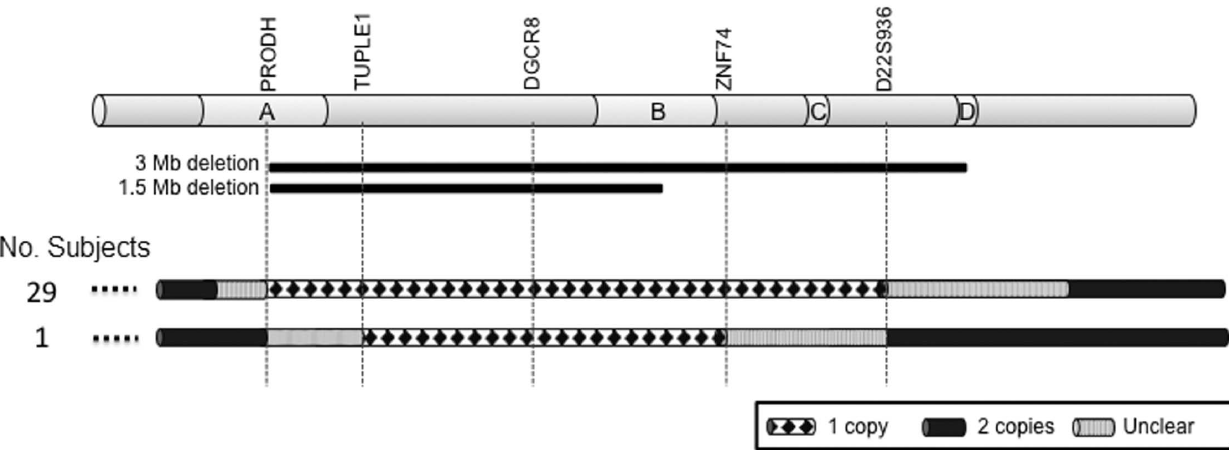
Figure 1. Diagram of the 22q11.2 deletion region. Schematic overview of chromosome 22 and the deletion endpoints characterized in the participants of this study using qPCR. Individuals 1 to 29 had a deletion between PRODH and D22S936 . One individual had the deletion located between the TUPLE1 and ZNF74 genes. Gene used, order of genes, LCRs A–D, and the common 3 Mb and 1.5 Mb deletion are indicated. Thin black lines indicate deleted region, solid black thick lines indicate chromosomal regions present in two copies, and gray boxes indicate uncertain location of the deletion breakpoints. Each numbered chromosome represents one individual.